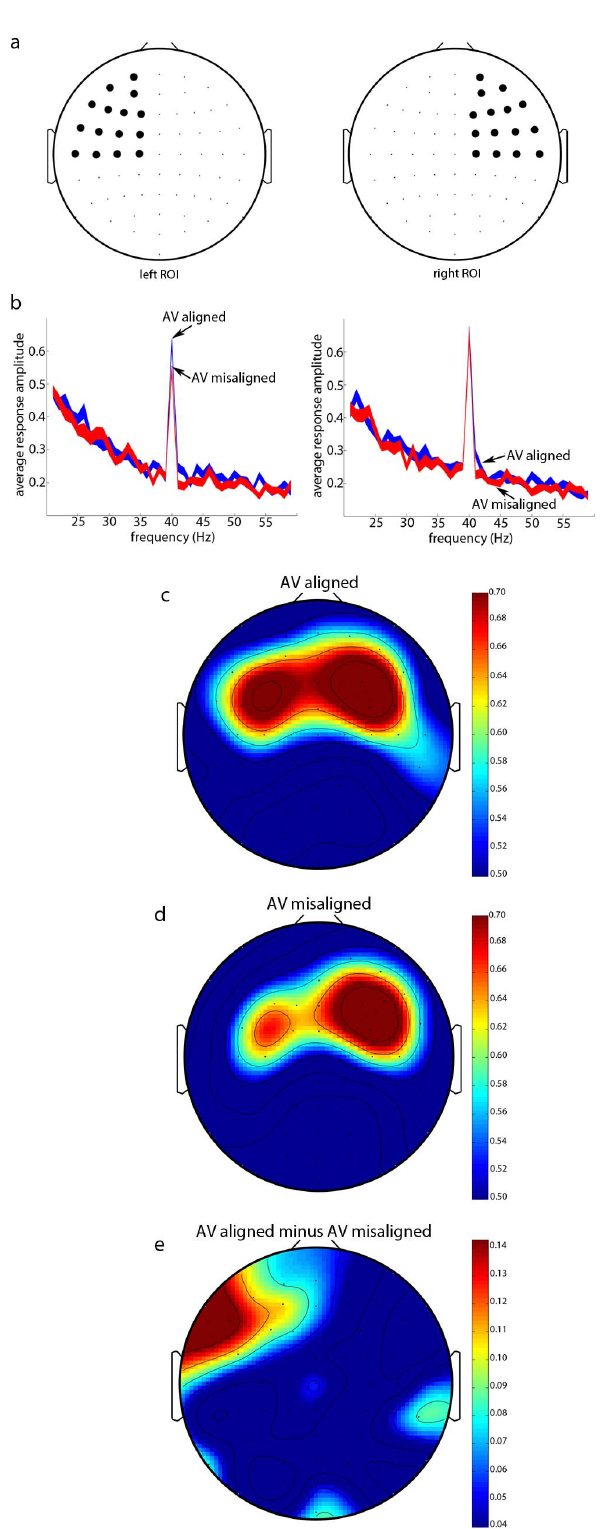
Figure 1. Group average ASSR amplitudes (N=28) to 40-Hz amplitude-modulated music while participants saw a dynam- ically aligned or misaligned visualizer. ASSR amplitudes were calculated from current-source density (CSD) transformed EEG scalp potentials. ( a ) Schematics showing the scalp sites comprising the